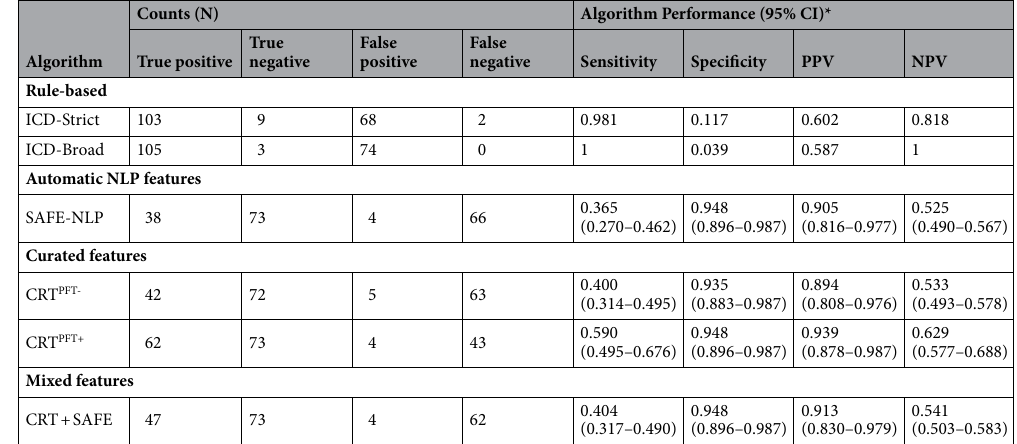
Table 2. Comparison of performance characteristics between different electronic medical record COPD classification algorithms within Mass General Brigham Biobank training set (N = 182). a COPD-specific